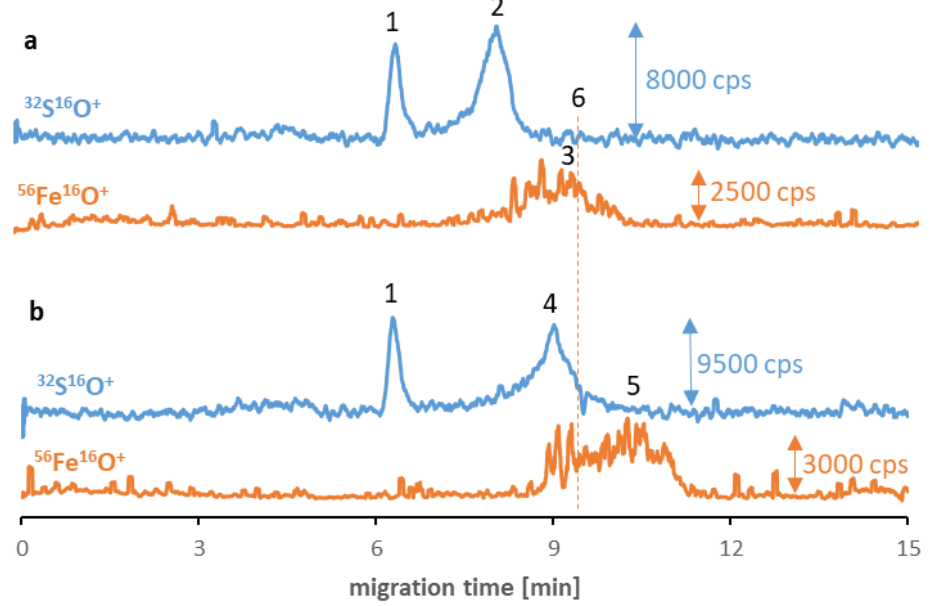
Figure 3. CE-ICP-MS/MS electropherograms’ MS/MS signals 32 S 16 O + and 56 Fe 16 O + of a mixture of Fe 3 O 4 @PEG (10–20 µg Fe/mL) and transferrin ( a ) and albumin ( b ), 1 mg/mL each, diluted in 10 mM phosphate buffer, pH 7.4, and 100 mM NaCl, and incubated at 37 °C for 6 h. Signal assignment: blank sulfur signal (1), transferrin (2), Fe 3 O 4 @PEG (3 and 5), albumin (4), Fe 3 O 4 @PEG analyzed individually (6); separation under optimized conditions (see Tables 1 and 2).